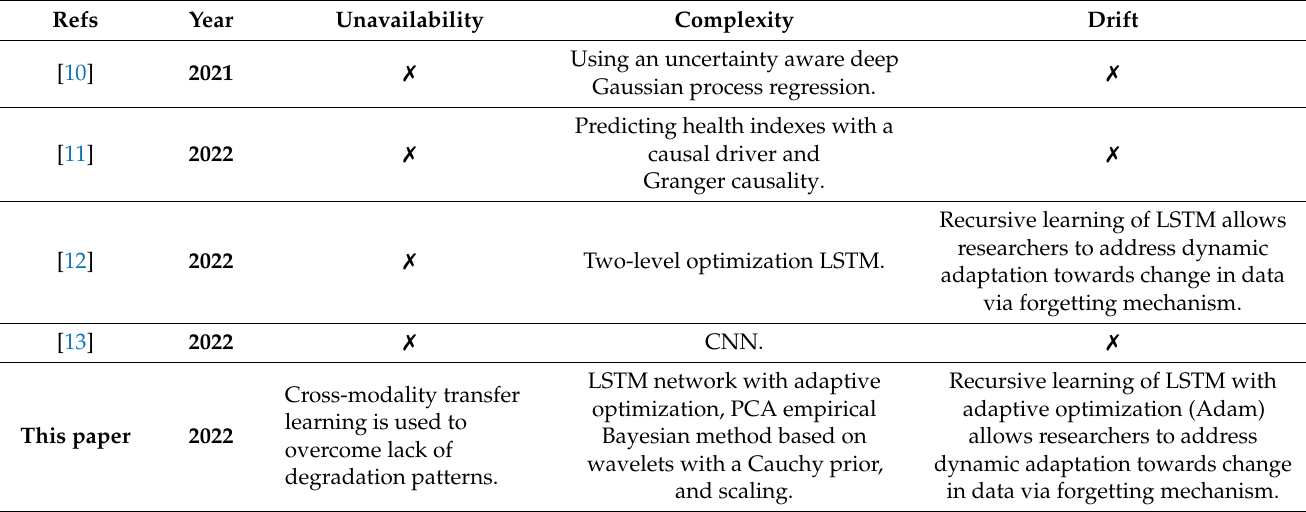
Table 1. Related works to N-CMAPSS